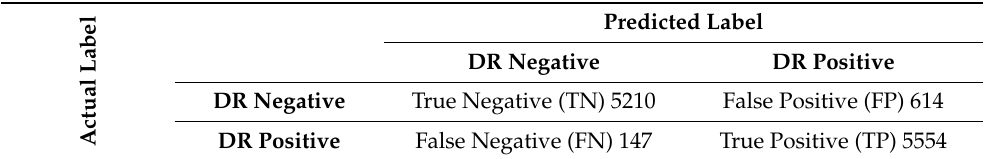
Table 1. Confusion matrix of Diabetic Retinopathy for model validation.